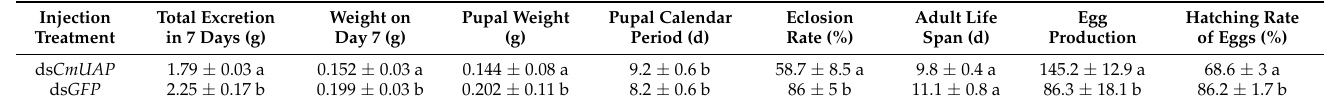
Table 3. Growth index of C. medinalis after dsRNA